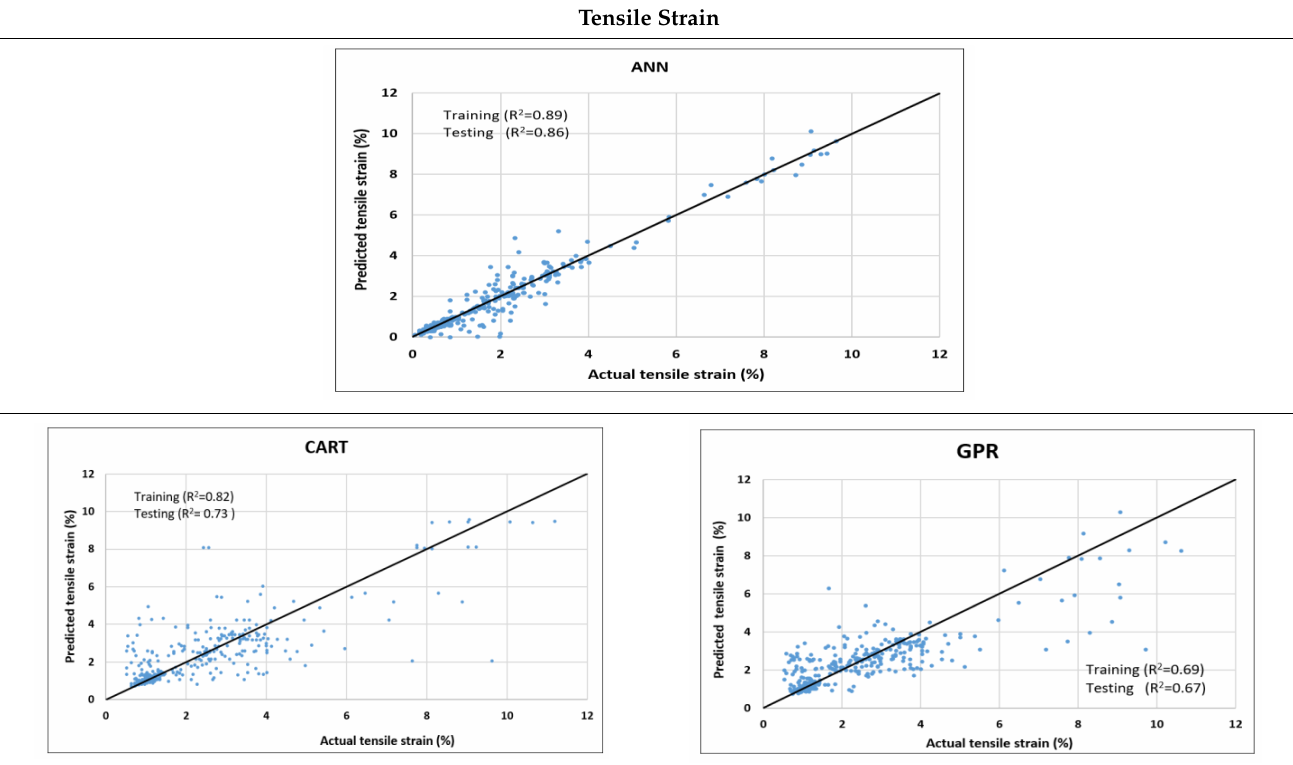
Table 4. Comparison of predicted and actual values of ductility